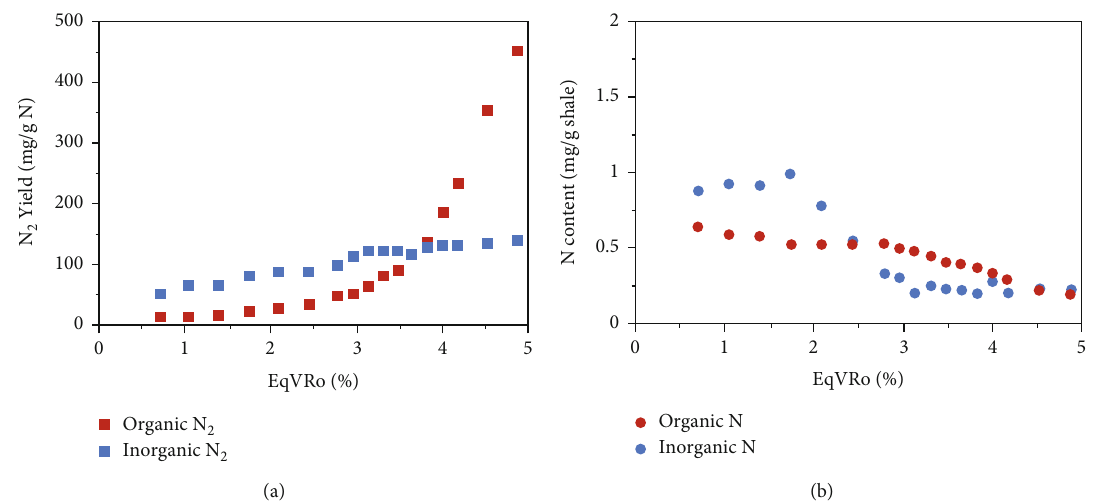
Figure 7: Cross-plots of the EqVRo value versus (a) N et al.